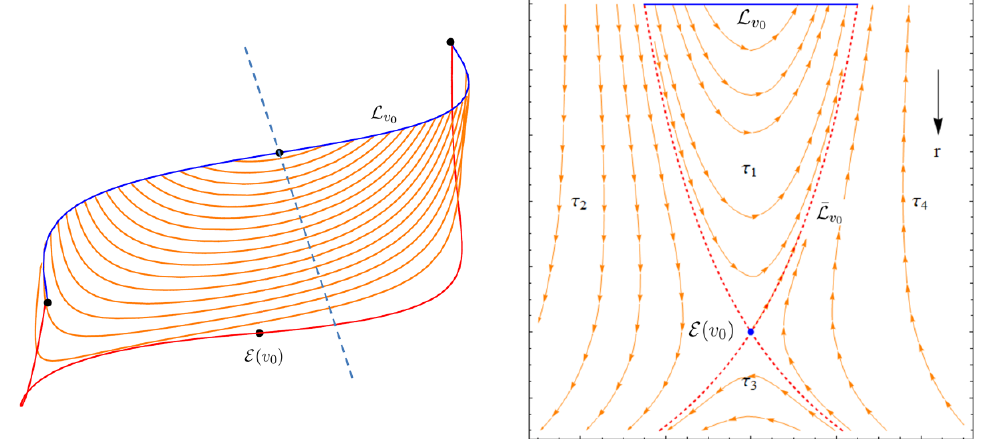
Figure 3 . The left (cid:12)gure gives an explicit diagram for a modular plane P ( v 0 ). The blue line is L v while the orange lines depict (cid:22) L r 0 denoted as E ( v 0 ). The other two black points are where L v The right (cid:12)gure is just the projection of the left (cid:12)gure to a (cid:13)at